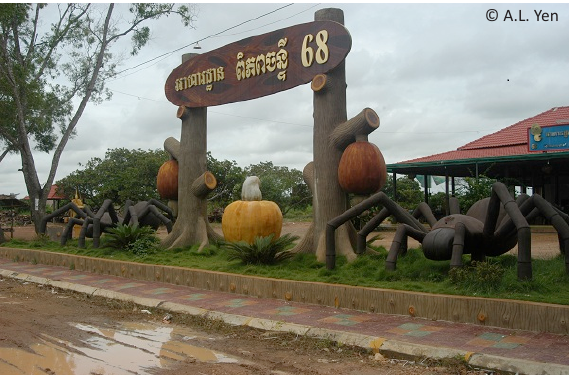
Image 1. Spiderville statues at Skun